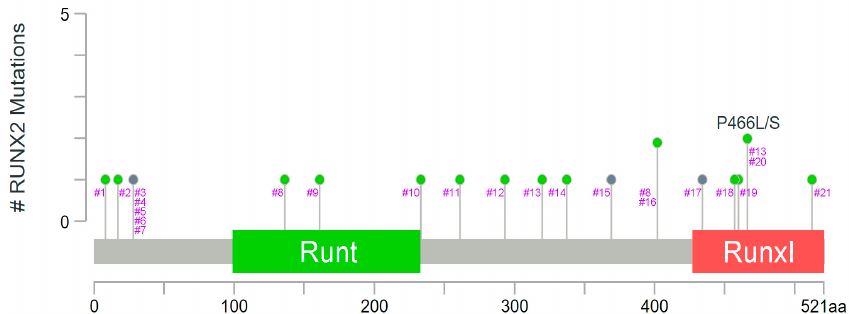
Figure 2. A pancancer study addressing whole genome data reveals the sites and types of RUNX2 mutations. Gray indicates the truncating mutations (putative driver) including nonsense, nonstop, frameshift deletion, and frameshift insertion. Light green indicates the missense mutations. Runt: Runt domain. RunxI: Runx inhibition domain. Data were adapted with permission from cBioPortal (https://docs.cbioportal.org/user-guide/faq/#can-i-use-figures-from-the-cbioportal-in-my-publica- tions-or-presentations) accessed on: 21 February 2023. Table 1. RUNX2 mutations in a pancancer study of whole genomes.